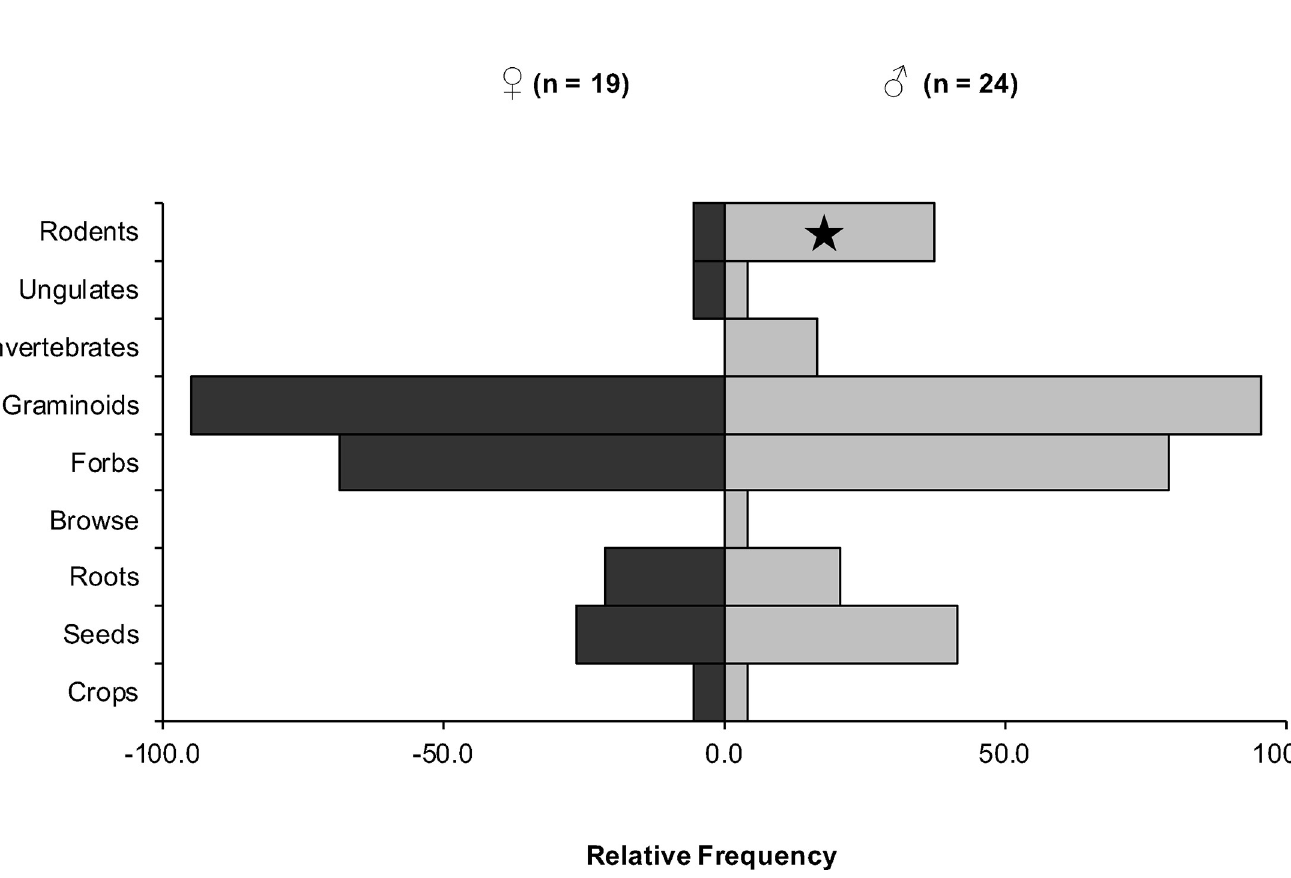
PLOS ONE | https://doi.org/10.1371/journal.pone.0225698 December26, 2019 10 /